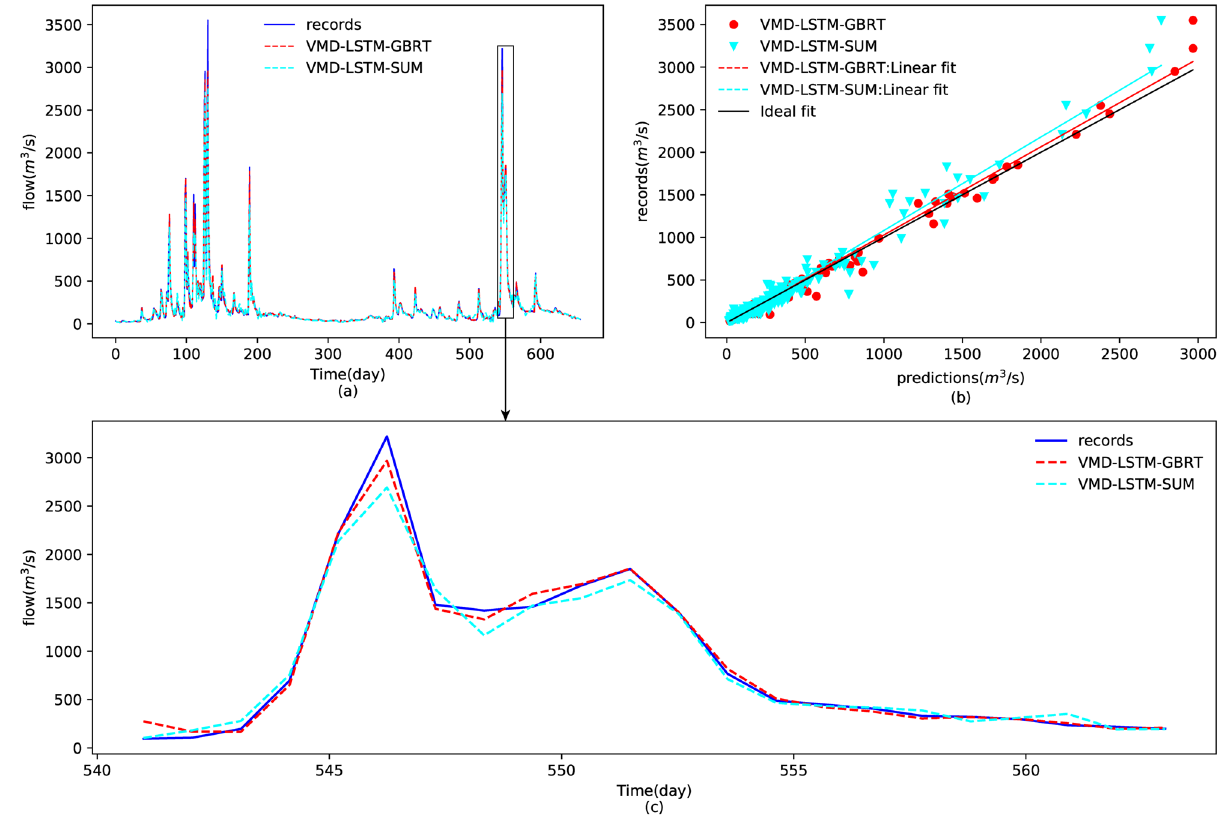
Figure 10. Comparison of prediction results of the test dataset using different ensemble techniques, GBRT and summation: ( a ) plots of the prediction results and records, ( b ) scatters for the test set (15/3/2013–31/12/2014), and ( c ) plots of the prediction results for the period